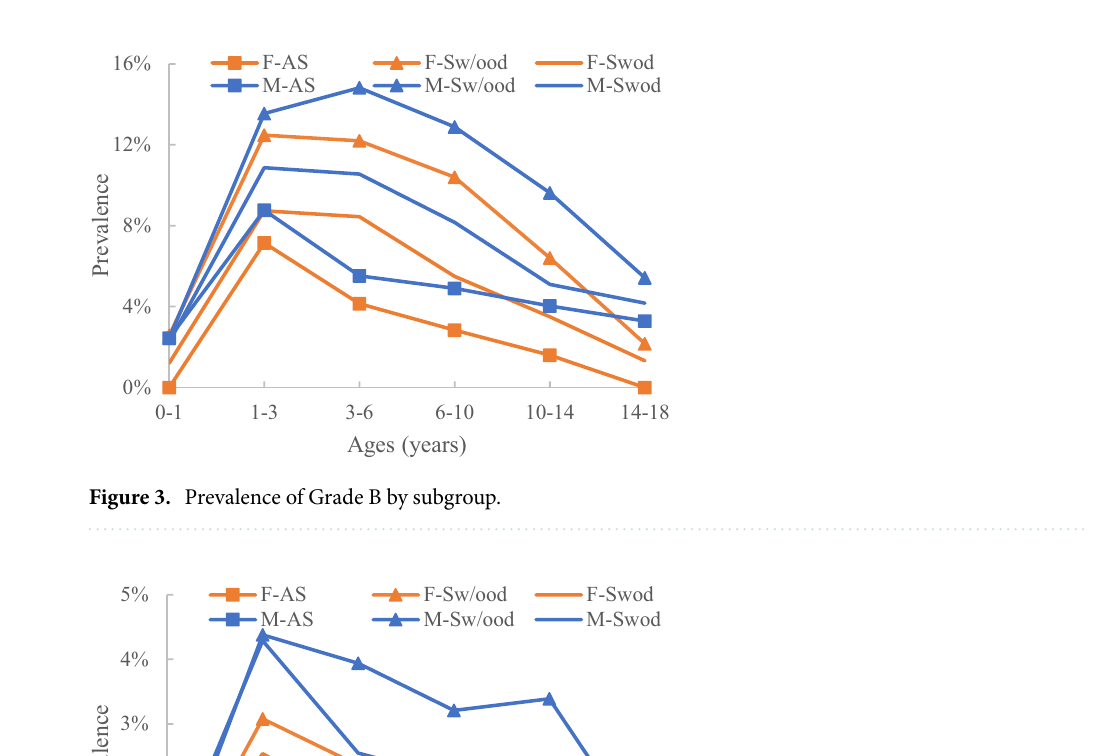
Figure 2. Prevalence of Grade C by subgroup.